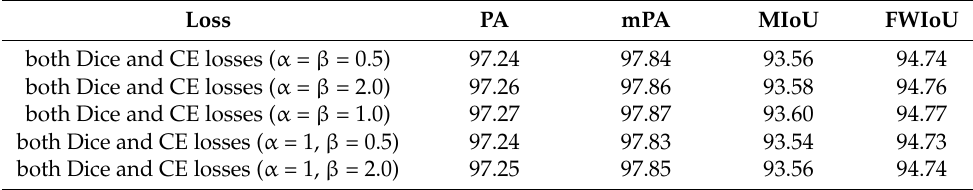
Table 6. The results of the experiment regarding the loss (%). Loss PA mPA MIoU FWIoU both Dice and CE losses ( α = β = 0.5) 97.24 97.84 93.56 94.74 both Dice and CE losses ( α = β = 2.0) 97.26 both Dice and CE losses ( α = β = 1.0) both Dice and CE losses ( α = 1, β = 0.5) both Dice and CE losses ( α = 1, β = 2.0)